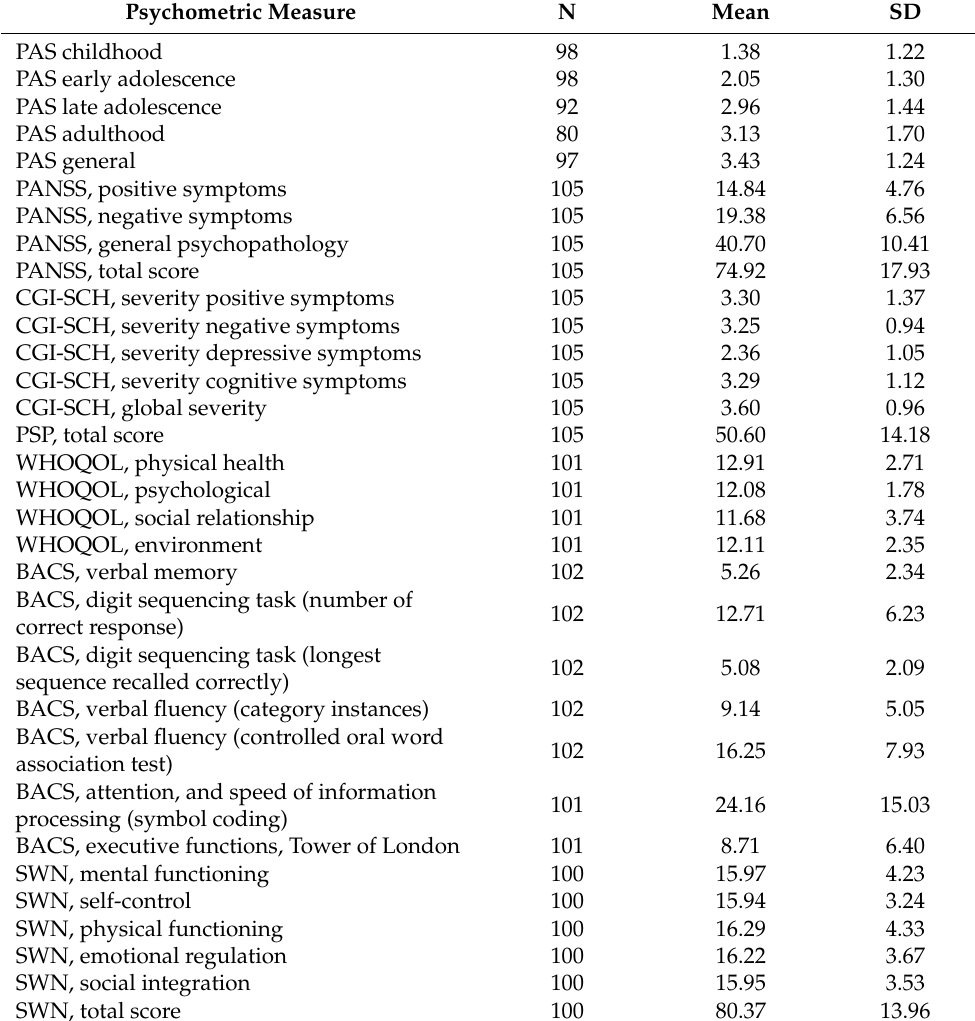
Table 2. Statistical properties of the psychometric measures applied in the sample of 105 patients with schizophrenia and schizoaffective